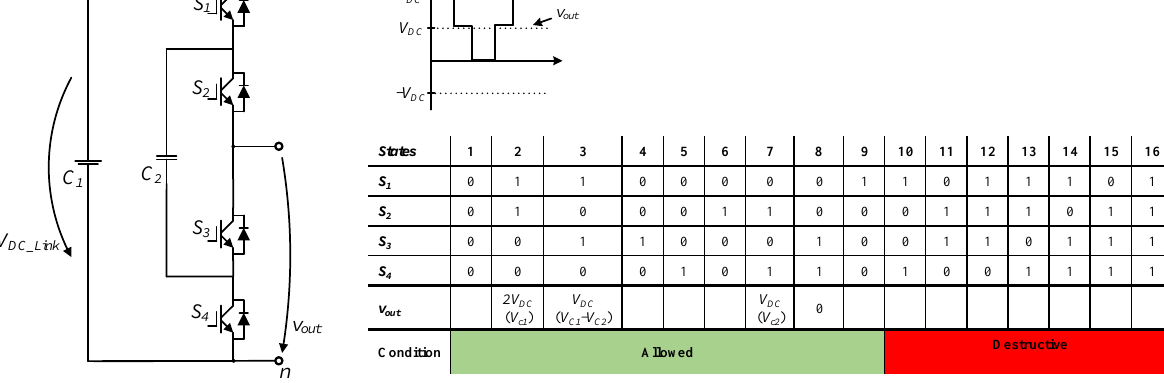
Table 1. Comparative table of submodule topologies.